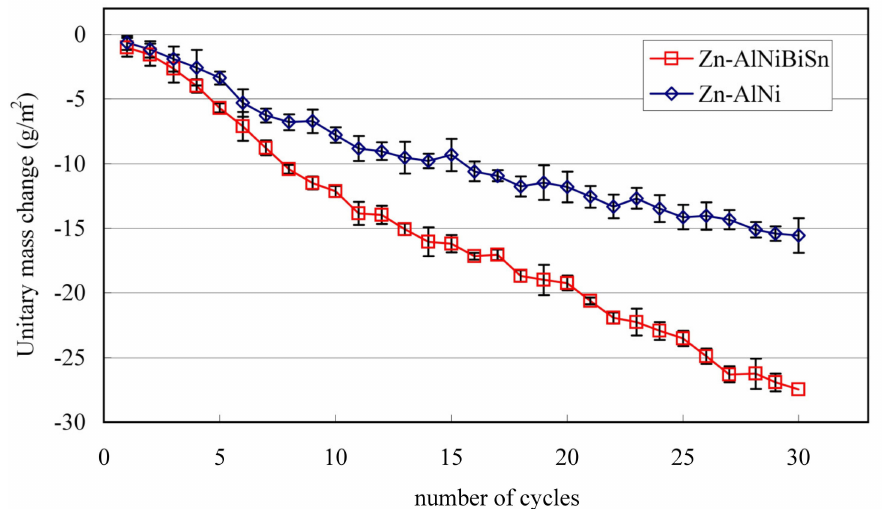
Figure 9. Unitary mass change of Zn-AlNiBiSn and Zn-AlNi coatings during exposure in the Koesternich